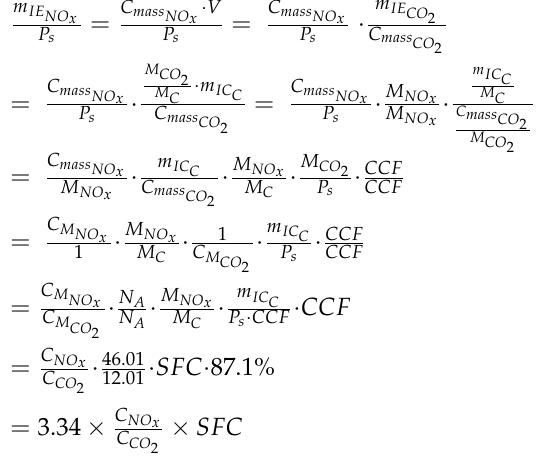
Table 1. The parameters of the real-time monitoring system.